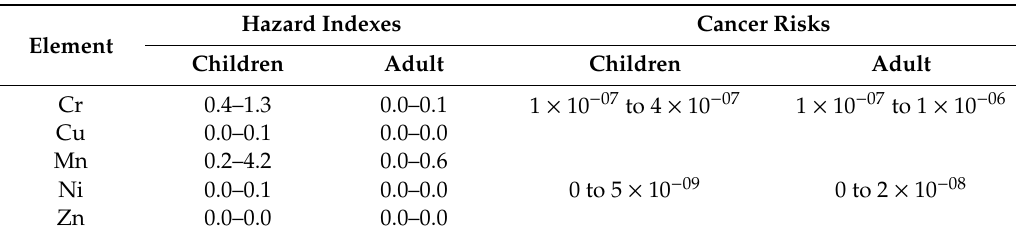
Table 8. Maximum and minimum range of hazard indexes and cancer risks due to soil exposure for potentially toxic elements, in Uttarakhand, India.